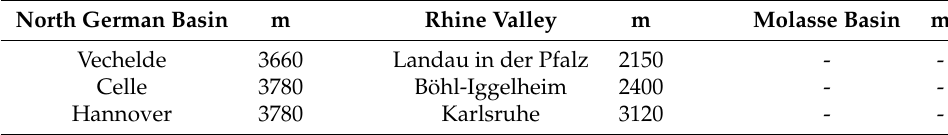
Table 2. Minimum depth for petrothermal usage (150 ◦